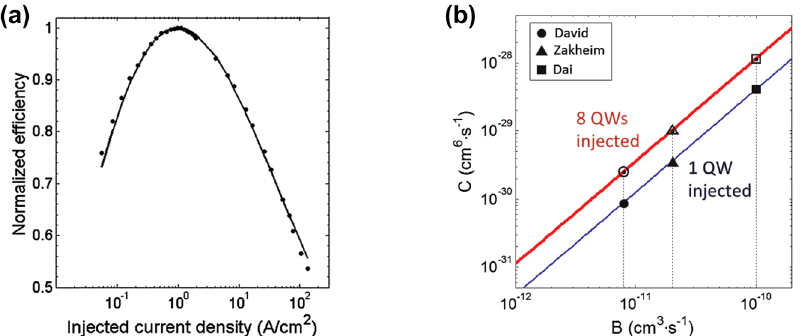
Figure 4: (a) Example of ABC fi t of EQE vs. injectedcurrentinaneight-QWLED.TheIQE is 76% as calculated from the position of the peak EQE;(b) calculated C coef fi cient as a function of B , considering that one or all eight QWs are populated, fi tting the IQE curve on the left. Data points correspond to different values of B reported in the litera- ture. Reproduced from the study by Weis- buch et al. [51]; see details